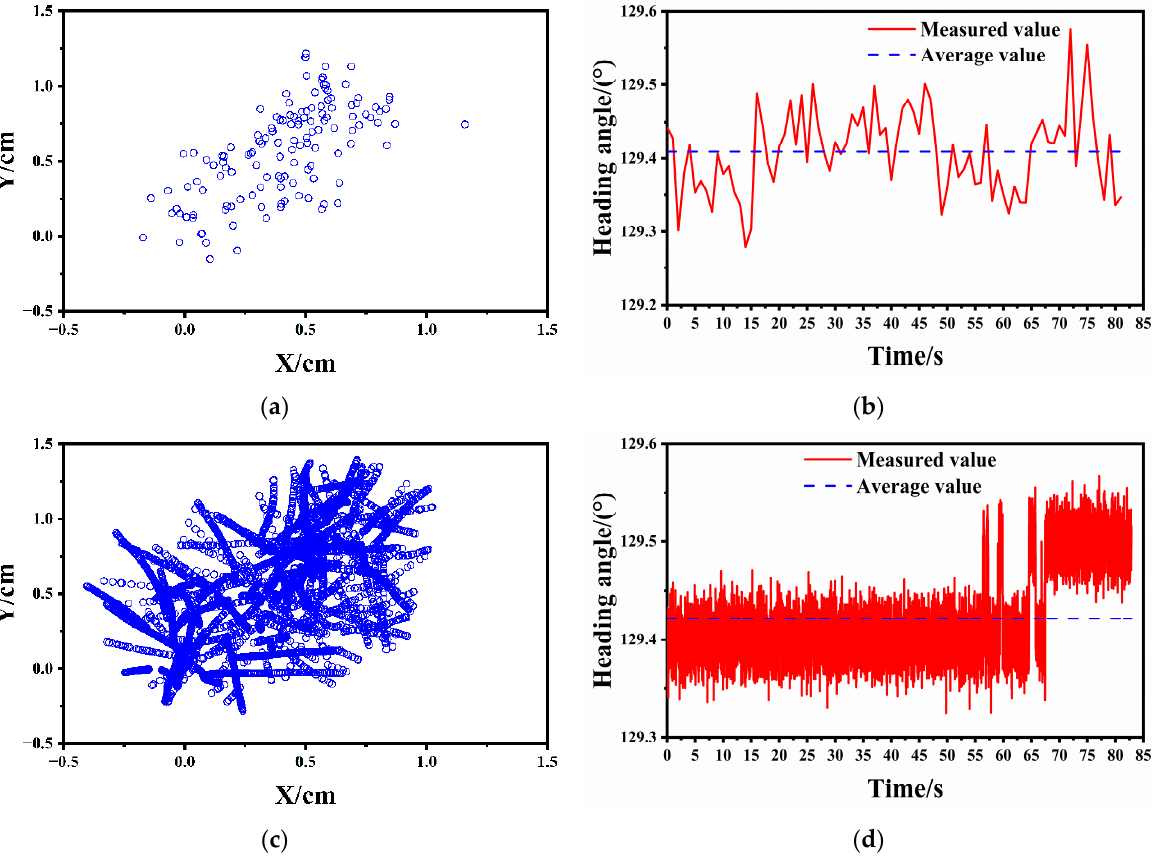
Figure 10. The positioning results of the spraying robot in the static experiments. ( a ) Positioning measurements of BDS in static state; ( b ) Heading angle measurements of BDS in static state; ( c ) Positioning measurements of BDS/IMU in static state; ( d ) Heading angle measurements of BDS/IMU in static state.